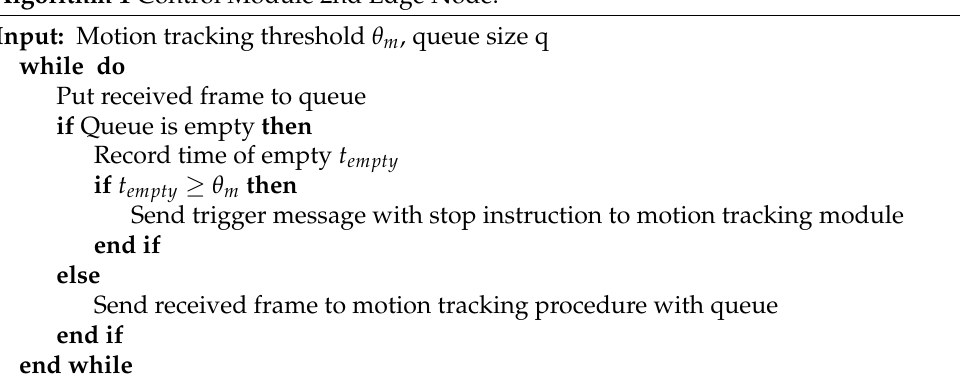
Algorithm 1 Control Module 2nd Edge